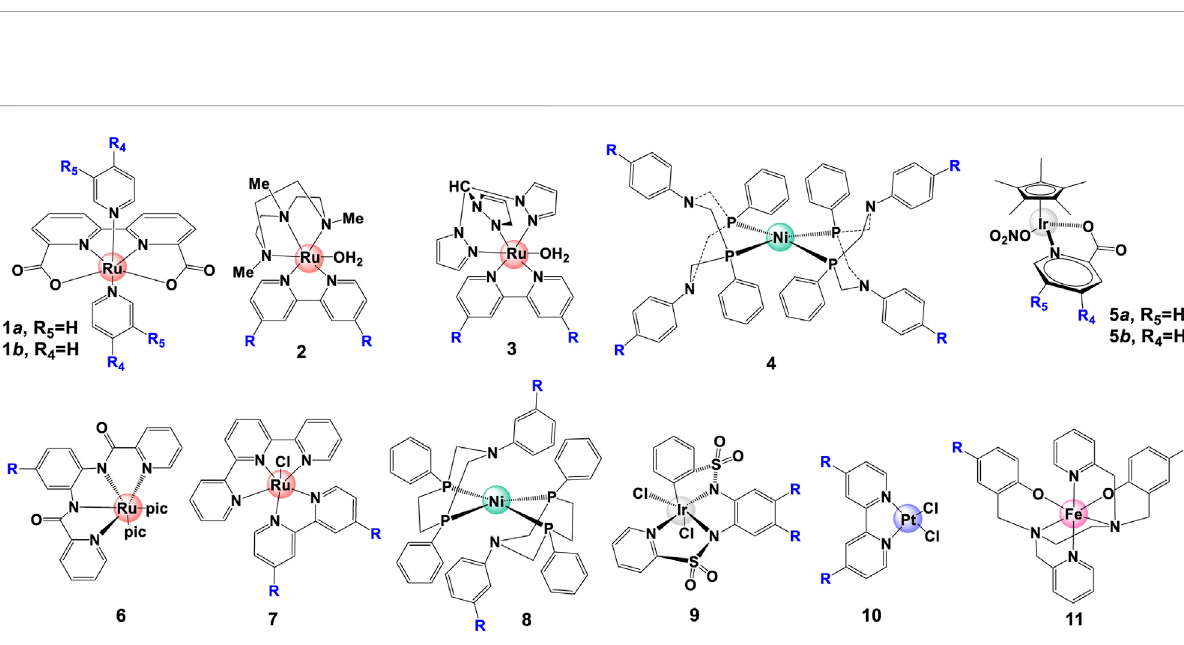
FIGURE 4 Selected water splitting catalysts with electron-withdrawing/-donating